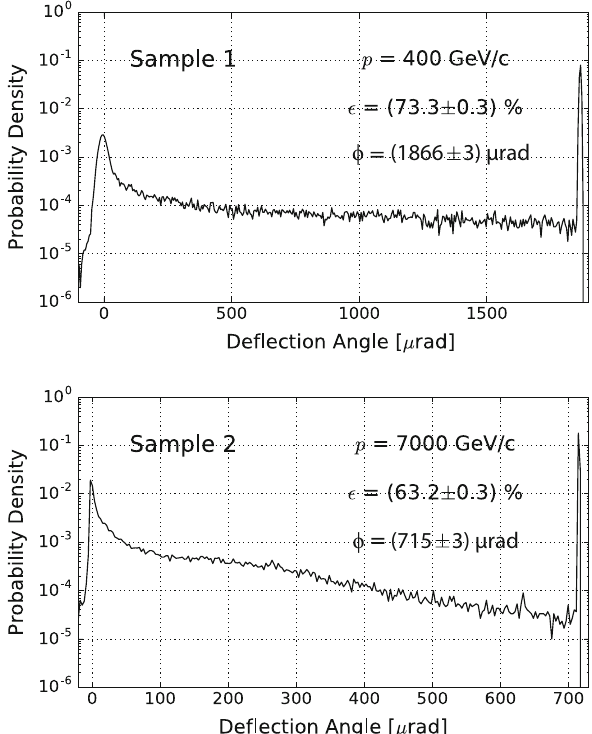
Fig. 5 Probabilitydistributionofthedeflectionefficiencyasafunction of the deflection angle after the interaction with the crystals. The proton momentum ( p ), the channeling deflection efficiency ( (cid:5) ), and the mean deflection angle ( φ ) are indicated on the